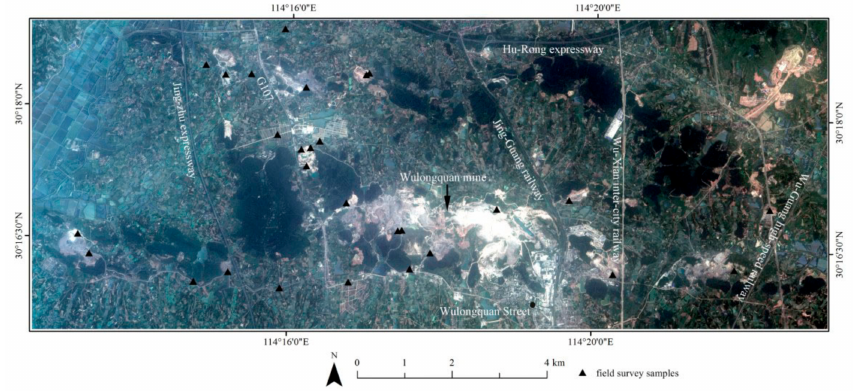
Figure 1. Image showing the study area and field sampling locations (revised from